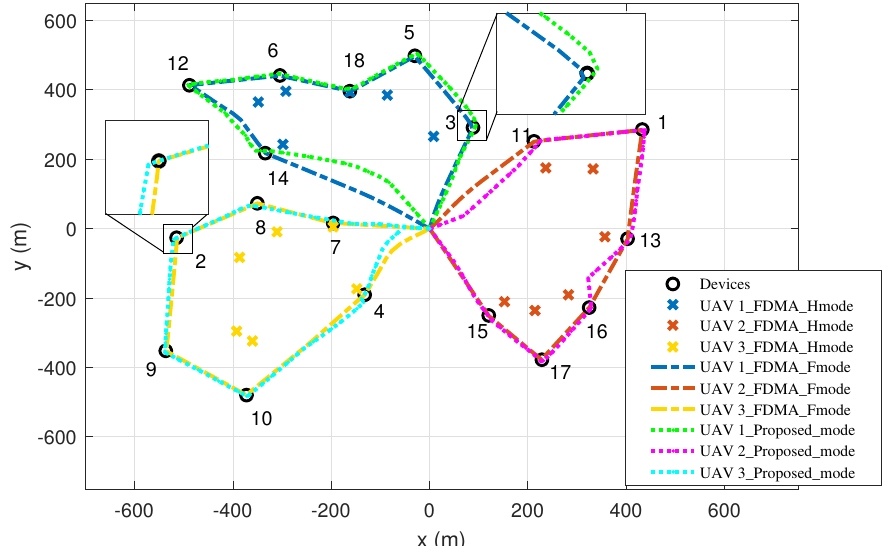
Figure 8. The optimal trajectories of multiple UAVs under different